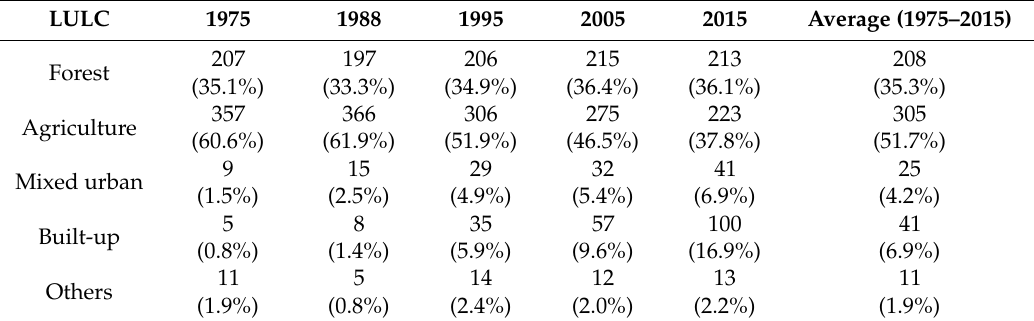
Table 3. LULC in the upper Bagmati catchment between 1975 and 2015 (areas shown in km 2 ). LULC